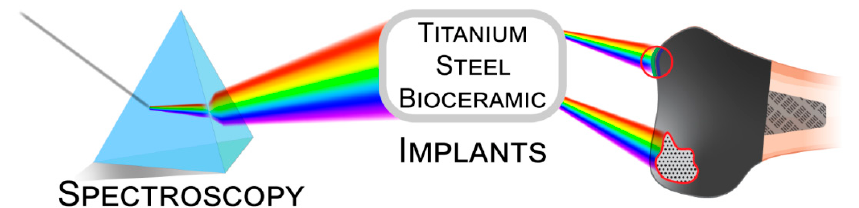
Figure 1. Spectroscopy utilizes parts of electromagnetic spectrum for analysis and studies of the processes occurring on the surface and in the subsurface regions of implants manufactured from metal alloys and bioceramic